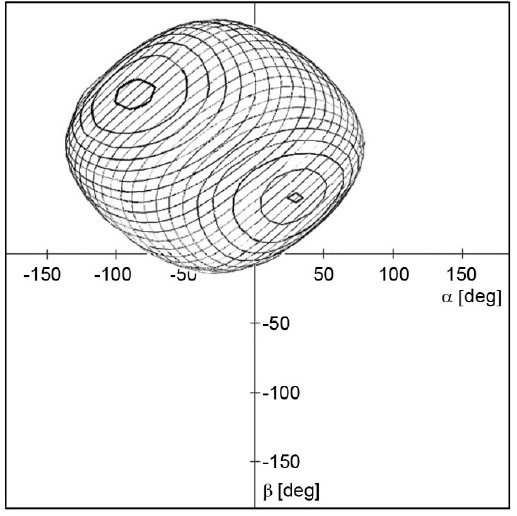
Figure 4. 2D projection of a spherical shape showing possible combinations of angles α , β and θ